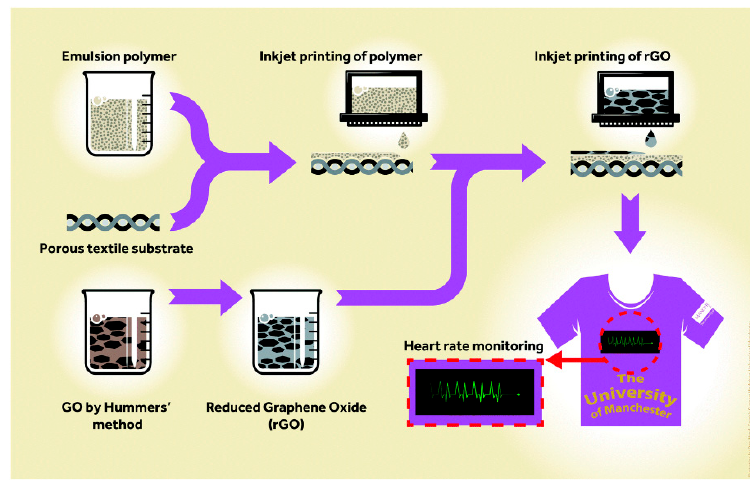
Figure 9. Diagram of the IJP process of graphene-based inks for e-textile manufacturing. Reproduced from [193], with permission from the Royal Society of Chemistry, 2017.